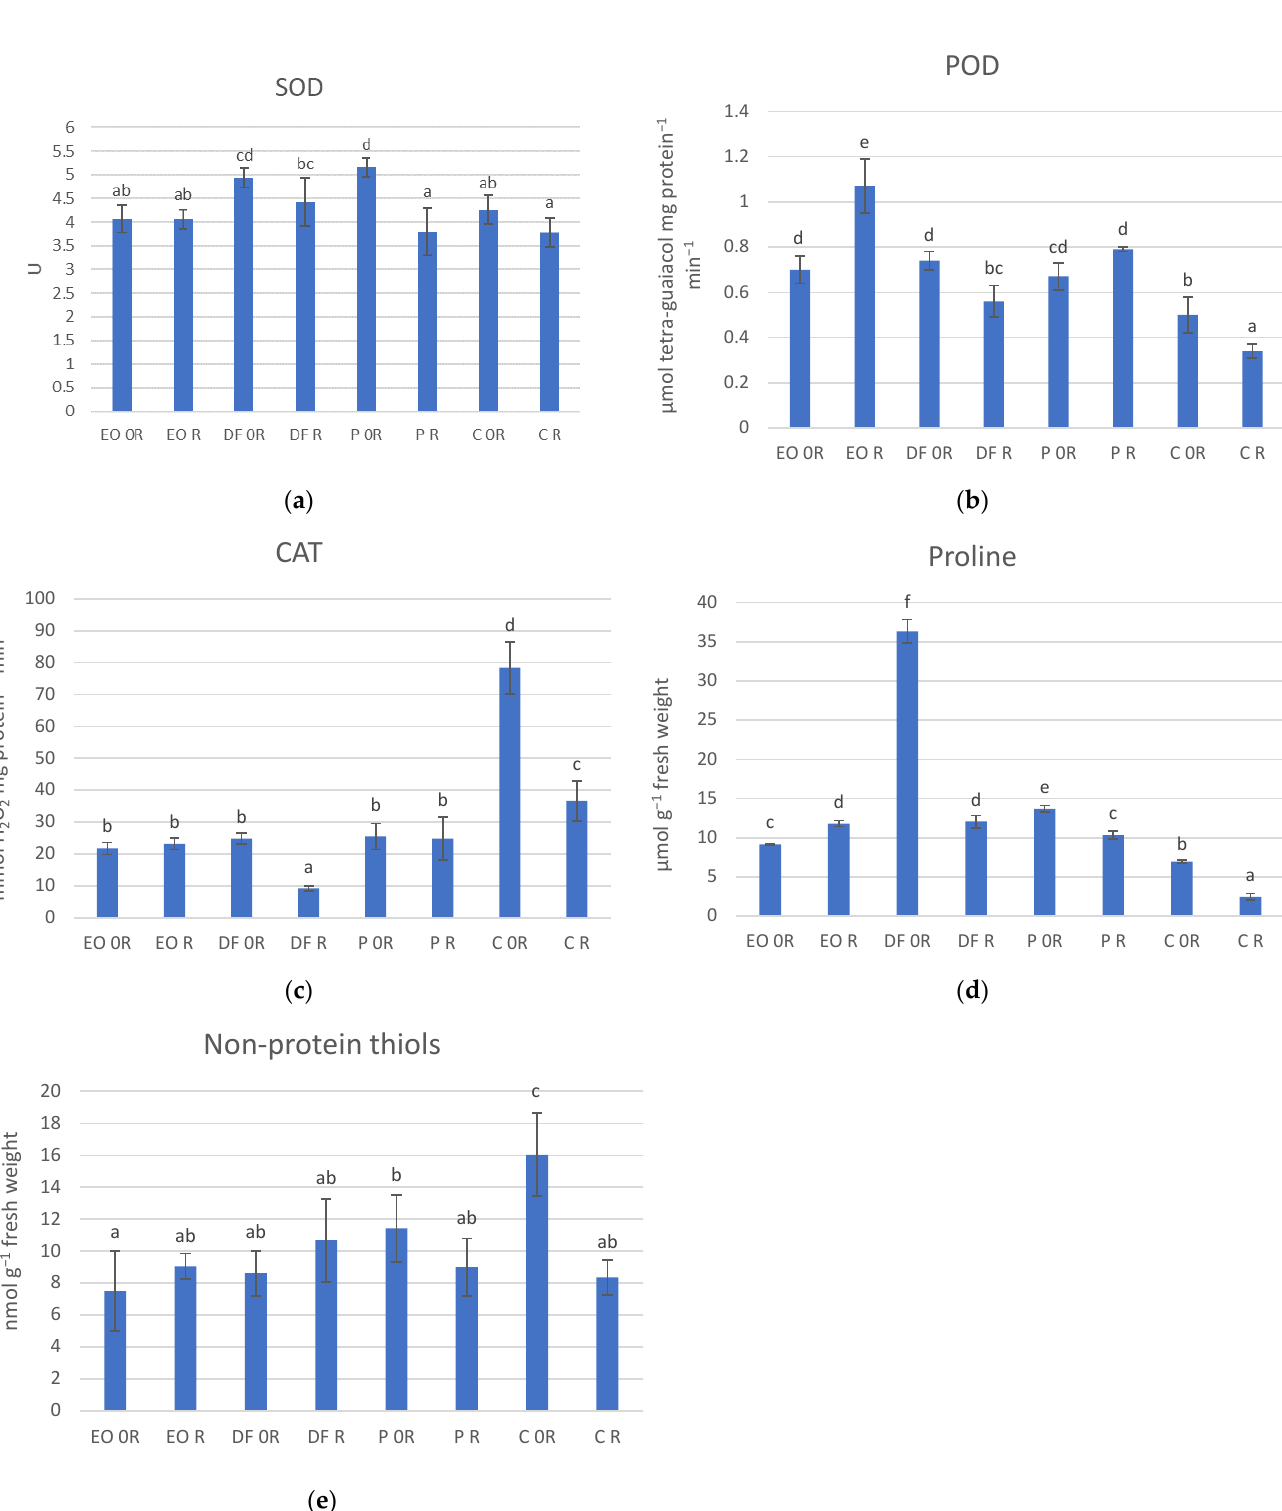
Figure 5. The effect of PDSs and bioremediation on the activity of antioxidant enzymes (superoxide dismutase ( a ), peroxidase ( b ), catalase ( c )) and the content of antioxidants (proline ( d ), non-protein thiols ( e )) in broad bean leaves. The means ( ± SE) for individual parameters that are marked with the same letters did not differ significantly according to the LSD test at p < 0.05. The symbols are the same as those in Table